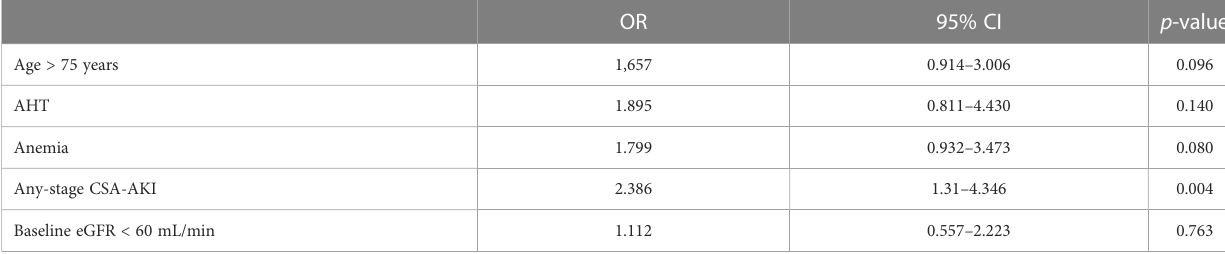
TABLE 5 Multivariate analysis of risk factors associated to 1-year MAKE.